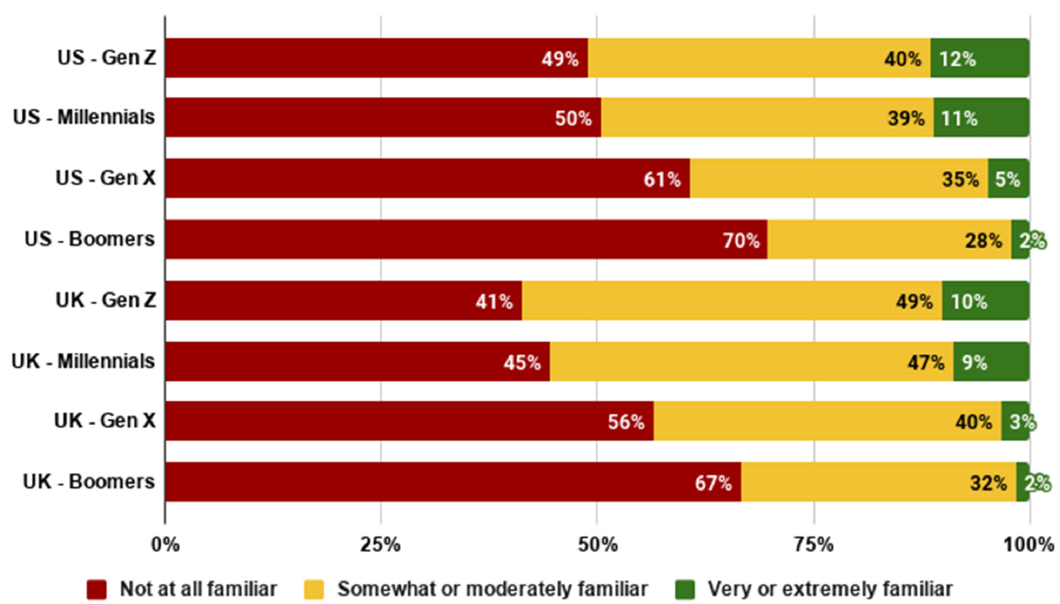
Figure 3. Familiarity with cultivated meat across generations. This generational difference was verified using ANOVAs, where the generations were treated as the independent variable and familiarity was the dependent variable. We observed a significant difference in familiarity between the generations in both the US ( F (3,2288) = 35.923, p < 0.001) and the UK ( F (3,2275) = 49.283, p < 0.001). 3.2. Support for the Technology This section addresses RQ2a, RQ2b, and RQ2c about support for cultivated meat. The data showed that before reading the additional supporting narrative, around one quarter of the general population in the UK and the US were very or extremely supportive of cultivated meat: this rose to over 35% after participants read the additional supportive narrative. In both countries, less than 25% were ‘not at all supportive’ of cultivated meat, and this fell to less than 20% after participants read the supporting narrative. Analyses indicated a significant difference between rates of acceptance before and after reading the passage in the US ( t( 2017) = − 14.041, p < 0.001) and the UK ( t( 2033) = − 14.571, p < 0.001). Overall support was higher amongst the early majority group, as would be expected (Figure 4). Amongst this group, we still see a significant increase in support pre versus post additional information in both the US ( t( 800) = − 17.123, p < 0.001) and the UK ( t( 802) = − 18.202, p < 0.001)